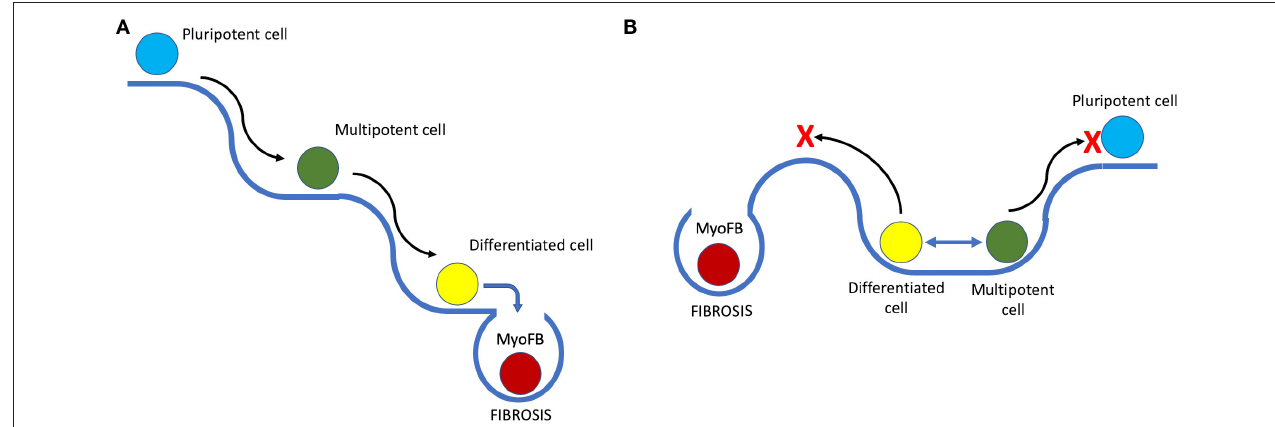
FIGURE 1 | Putative scheme of the epigenetic landscape in species with high and low regenerative capacities and its influence on cell fate. (A) Epigenetic landscape in species with low regeneration. Black arrows represent differentiation, and slopes indicate low probability of phenotype reversion or dedifferentiation; blue arrow highlights the moment when, after damage, a myofibroblast (MyoFB) “falls off the cliff,” and an irreversible cell fate decision is made, followed by scarring. (B) Depiction of a different landscape that favors phenotype change and transient dedifferentiation with limited stemness acquisition (blue 2-headed arrow on the plateau). The red cross marks potential restriction on both pluripotency acquisition and fibrosis imposed by the epigenetic landscape, reducing probability of an unfavorable cell fate decision after damage.